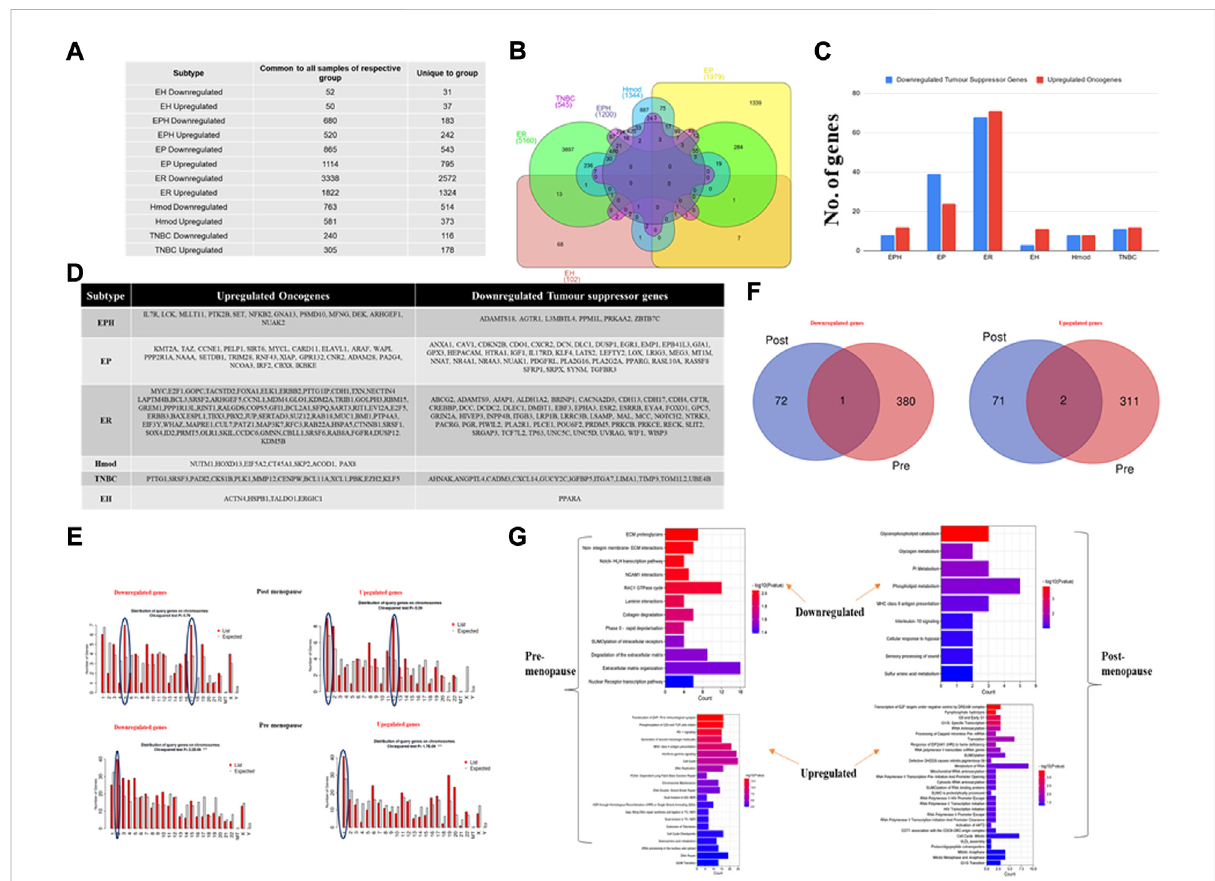
FIGURE 2 (A) Table showing thenumber of differentially expressedgenesthat are common to all patients inasubtype and unique geneswhen compared to other subtypes of breast cancer. (B) Venn diagram showing common and unique genes among different subtypes of breast cancer patients. (C) A bar graph depicting the number of upregulated oncogenes and downregulated tumor suppressor genes in six subtypes of Indian breast cancerpatientsamples. (D) Atablewithalistofupregulatedoncogenesanddownregulatedtumorsuppressorgenes. (E)